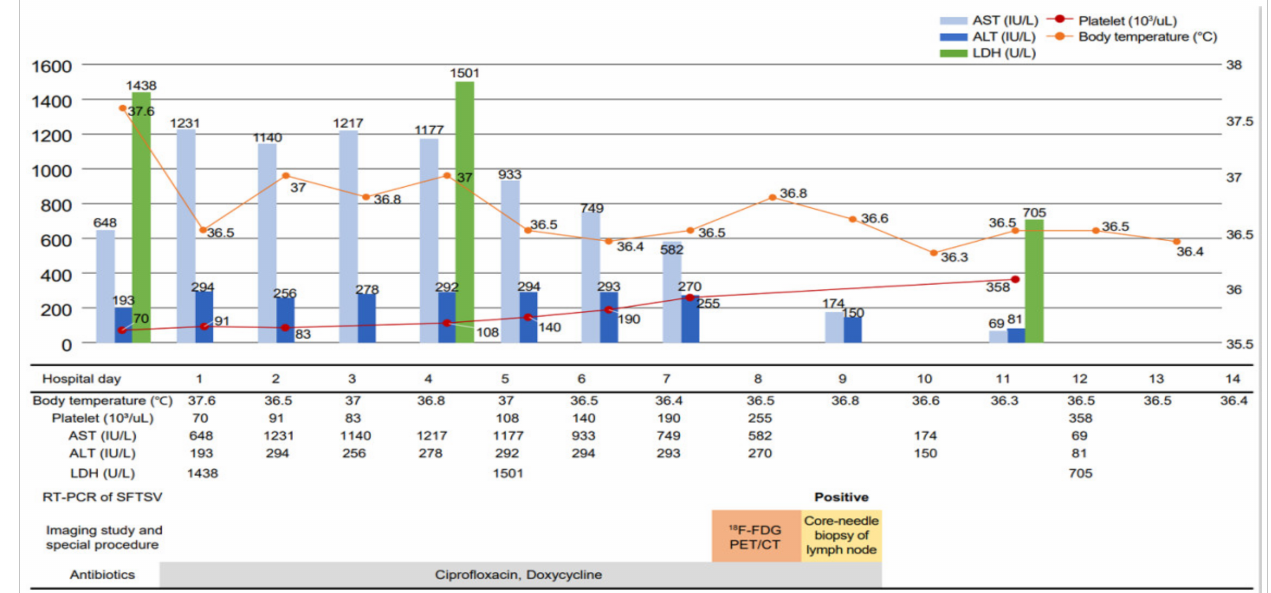
Figure 1. Changes in laboratory results and body temperature according to the course of hospitalization.